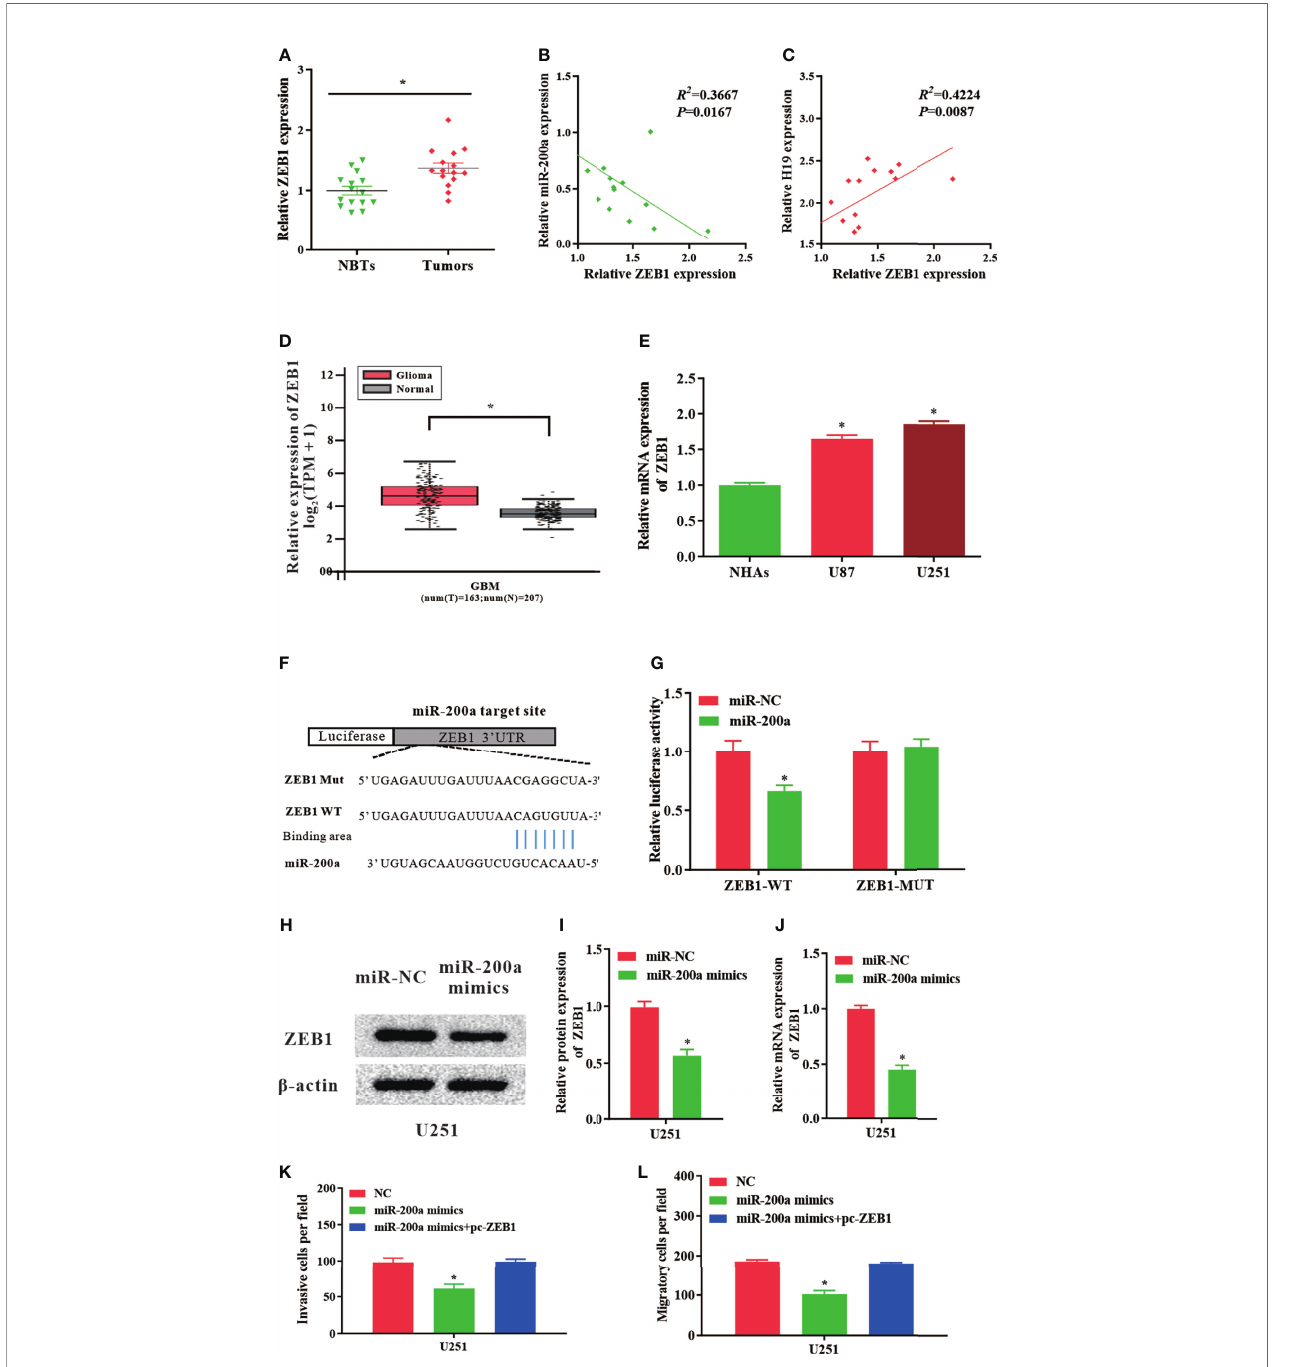
FIGURE 4 | ZEB1 levels are modulated by miR − 200a in glioma cells. (A) ZEB1 expression was assessed in glioma tissues and paired para − tumorous. (B) The RNA levels of ZEB1 and miR − 200a inversely correlated in glioma tissues (R 2 = 0.3667; P = 0.0167). (C) The RNA levels of ZEB1 and H19 correlated in glioma tissues (R 2 = 0.4224; P = 0.0087). (D) GEPIA database revealed signi fi cant up-regulation of ZEB1 in glioma tissues (GBM, T = 163, N = 207). Boxplot illustrated log2 (TPM+1) on a log-scale. (E) ZEB1 expression was increased in glioma cell lines. (F) Putative binding sequences of miR-200a on ZEB1 transcript. (G) Overexpression of miR-200a resulted in signi fi cant decrease in ZEB1-WT-mediated luciferase activity but not in mutant control. (H, I) Protein levels of ZEB1 were determined in U251 cells transfected with miR-NC or miR-200a mimics. (J) RT − qPCR was performed to evaluate the ZEB1 expression in transfected U251 cells. (K, L) The invasion and migration of transfected U251 cells were examined using Transwell assay. Data were presented as mean ± SEM; * P < 0.05 vs NHAs or control group. NHAs, normal human astrocytes; NBTs, normal brain tissues; NC, negative